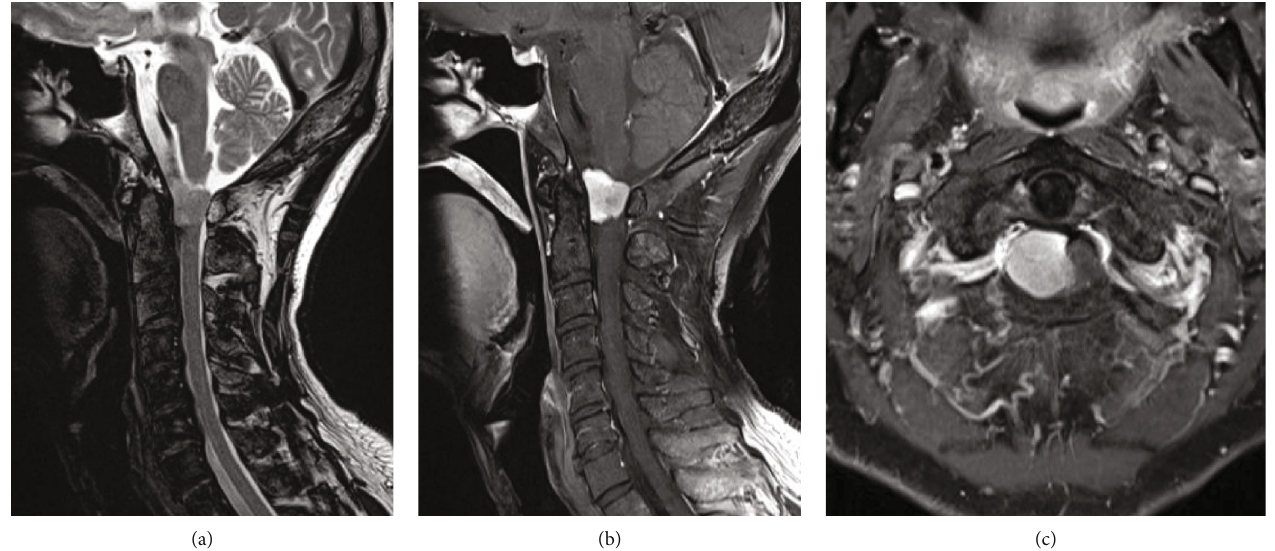
Figure 1: (a) T2-weighted sagittal MRI of the cervical spine showed a tumor in the craniocervical junction. (b, c) MRI followed by the intravenous administration of gadolinium-diethylenetriaminepentaacetic acid (Gd-DTPA) showed a homogeneously enhanced intradural tumor without obvious dural tail sign.